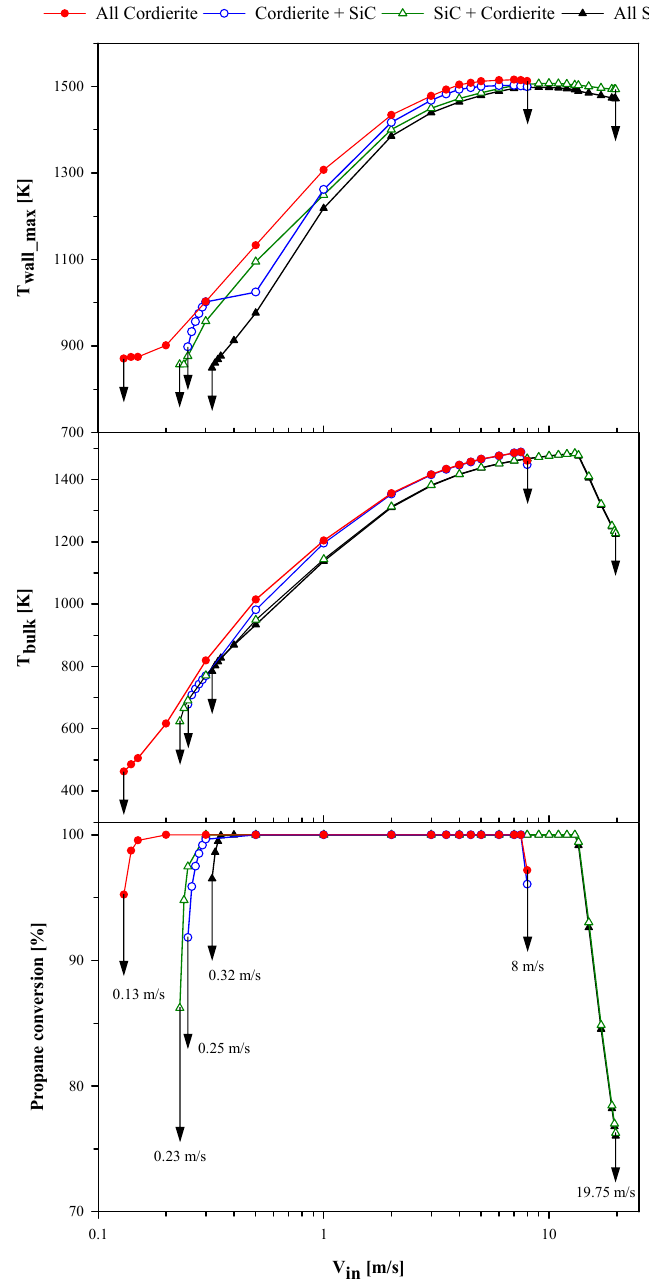
Figure 7. Maximum wall temperature, T wall_max , (outlet) bulk gas temperature, T bulk , and (outlet) propane conversion versus V in : Cordierite + SiC and SiC + Cordierite. For the sake of comparison, the plots obtained in the cases All Cordierite and All SiC are also shown. Arrows indicate extinction (at low values of V in ) and blowout (at high values of V in ).